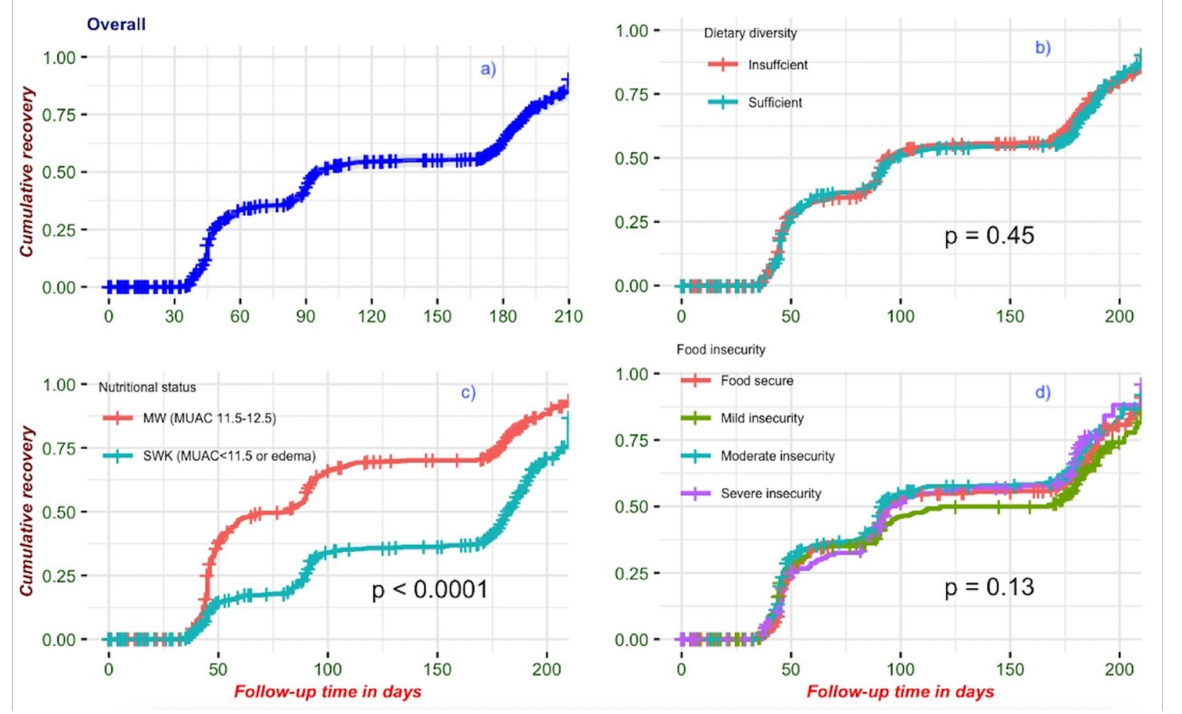
Figure 4. Kaplan–Meier curves for the cumulative rate of recovery: ( a ) overall cumulative recovery; ( b ) cumulative recovery by dietary diversity; ( c ) cumulative recovery by baseline nutritional status; ( d ) cumulative recovery by food insecurity status. Table 2. Rate of recovery by food